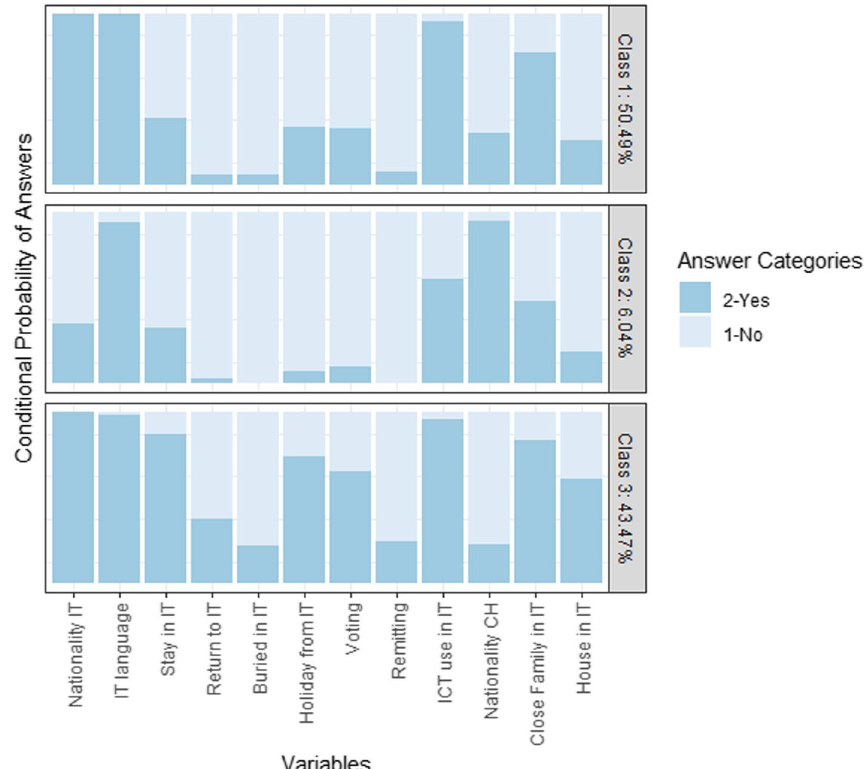
Fig. 2 Conditional probabilities for LCA model with three latent classes